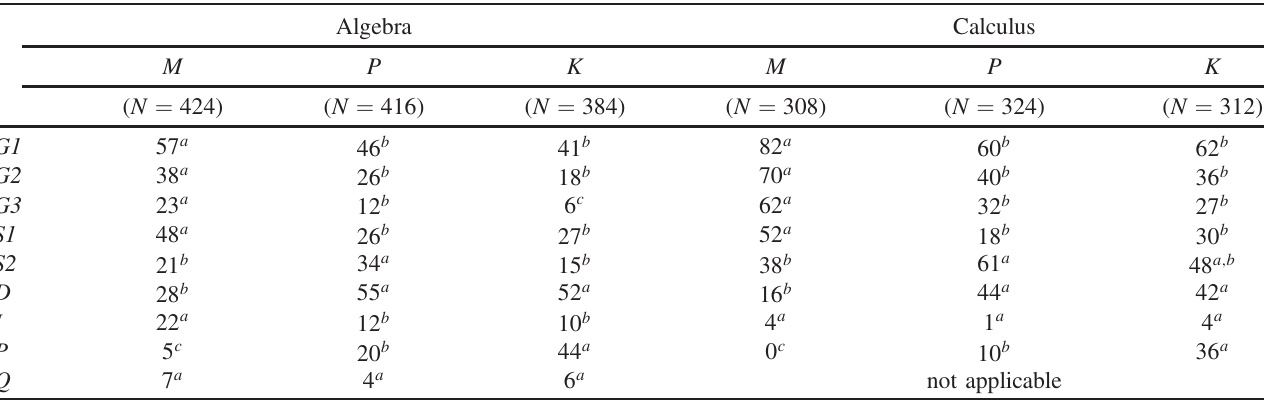
TABLE VIII. Prevalence of arguments per context, expressed as percentages. N is the number of items per type of context. Significant differences in the use of arguments between the different contexts for both educational backgrounds are represented by superscripts. Prevalences sharing the same superscript are not significantly different from each other.